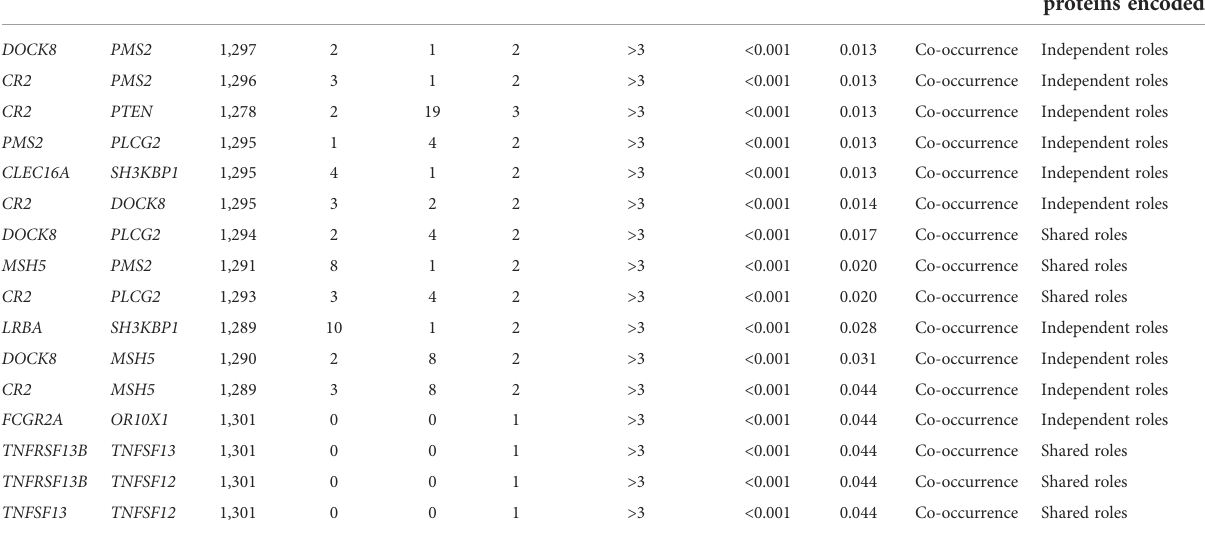
TABLE 5 Co-occurrence of mutations in the analyzed population calculated by the odds ratio method in cBioPortal. Gene A Tendency Associations with